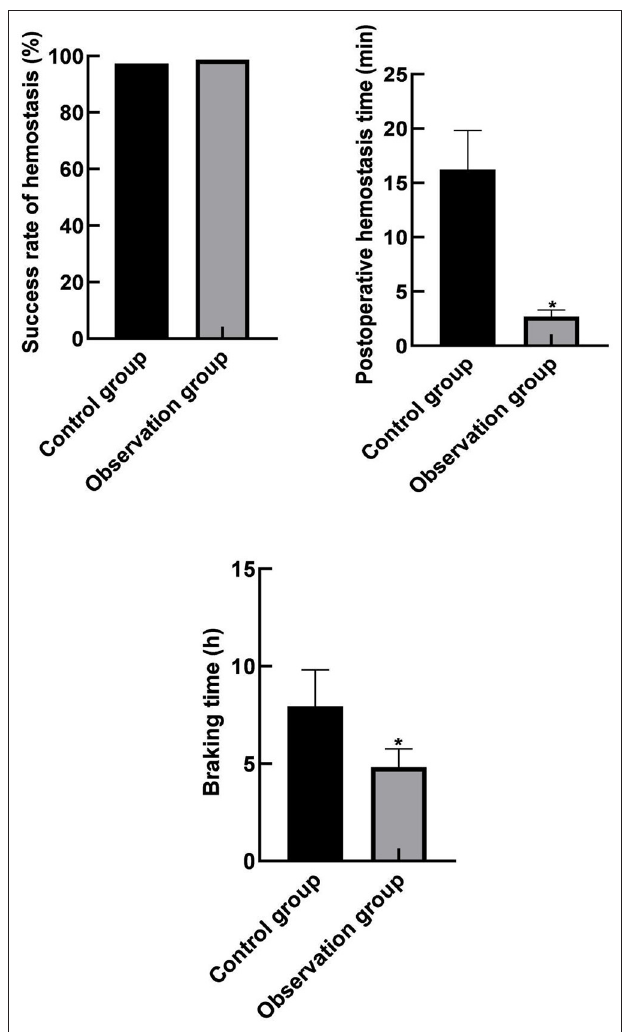
FIGURE 1 | Comparison of hemostatic efficacy indicators between the two groups. Compared with the control group, * p <